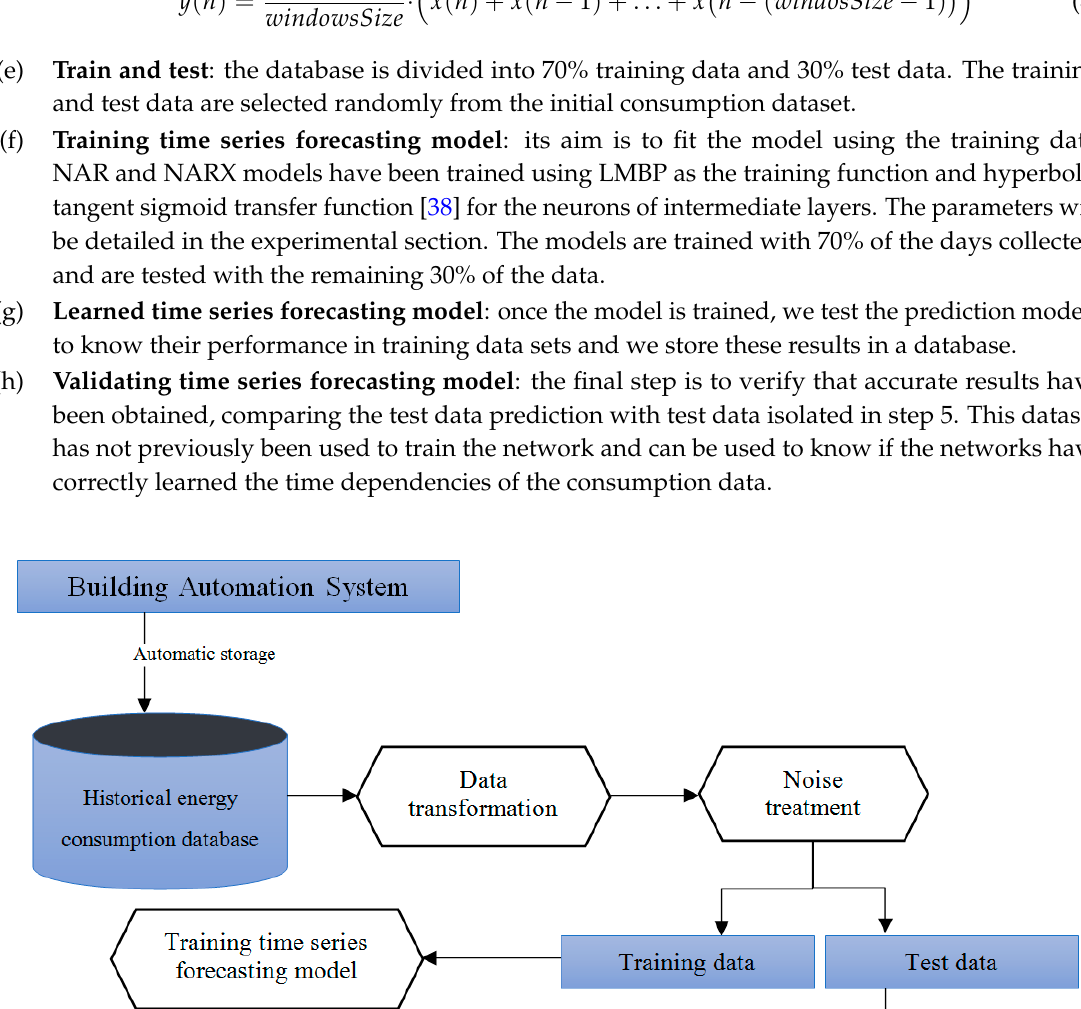
Figure 2. Non ‐ linear autoregressive with exogenous (External) inputs (NARX).